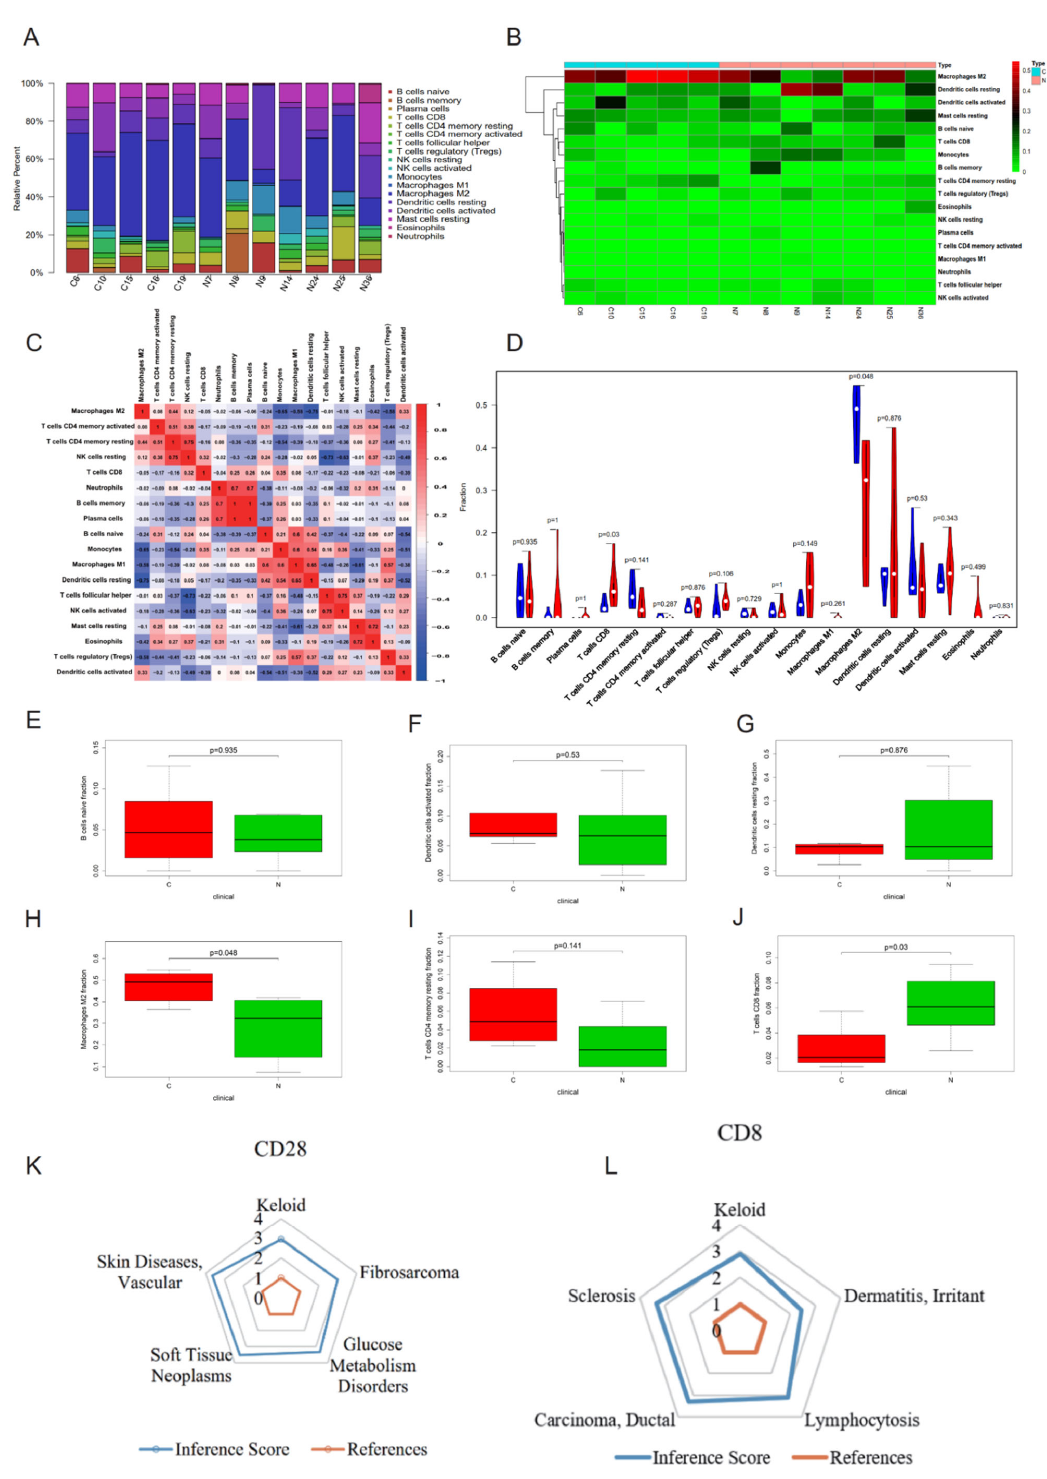
Figure 6. ( A ) Fractions of immune cells between Groups N and C. ( B ) Heatmap of immune cells between Groups N and C. ( C ) A correlational heatmap of immune cells of keloids. ( D ) A violin plot of immune cells between Groups N and C; blue denotes Group C, and red denotes Group N. ( E – J ) Quantitative analysis of immune cells by immune infiltration analysis. ( K , L ) CD28 and CD8 were further analyzed with the Comparative Toxicogenomics